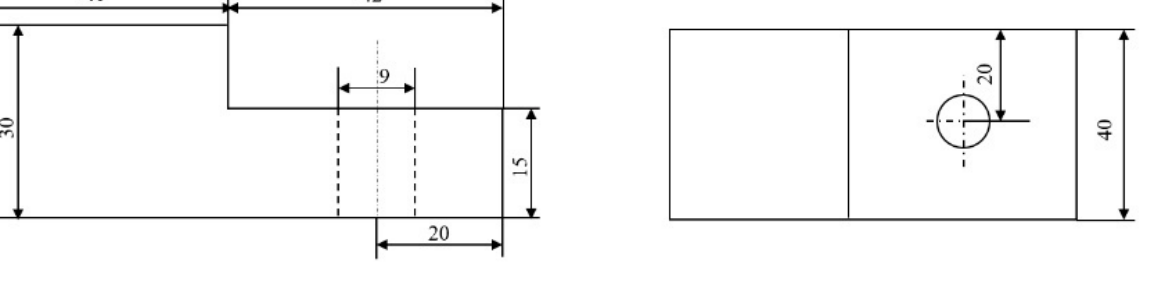
Figure 8. Dimensions of plates (mm).